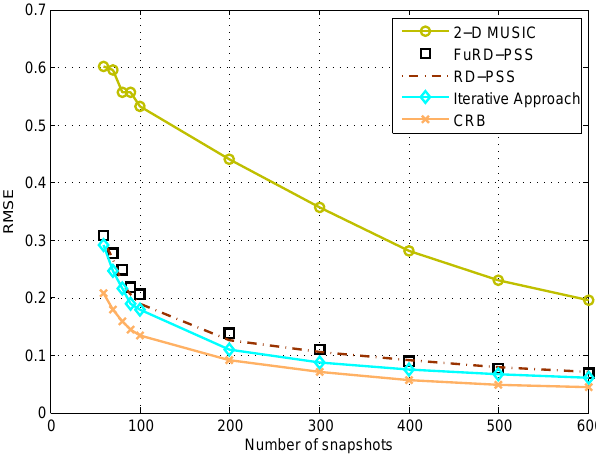
Figure 4. RMSE comparison of different methods versus the number of